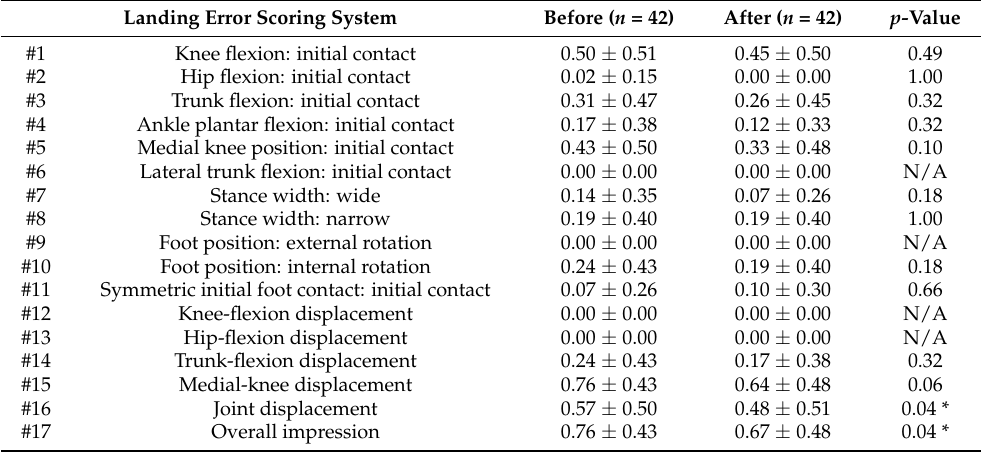
Table 3. The difference before and after applying dynamic tape in individual items.